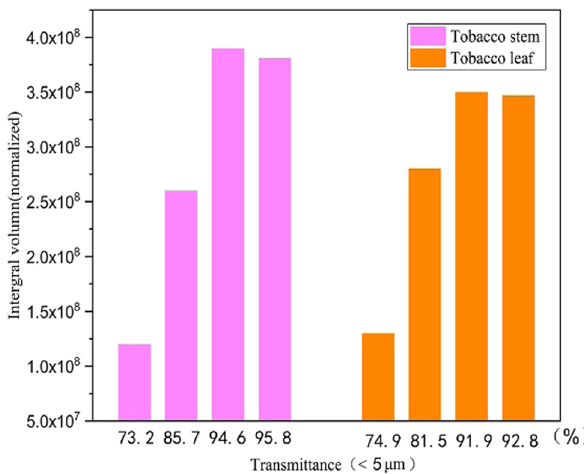
Figure 6: 2D NMR contour integral of lignin from tobacco stem and tobacco leaf cell walls with di ff erent transmittances. Lignin = Integral ( S 2/6 ) + Integral ( G 2 + G 6 ) + Integral ( PB 2/6 )